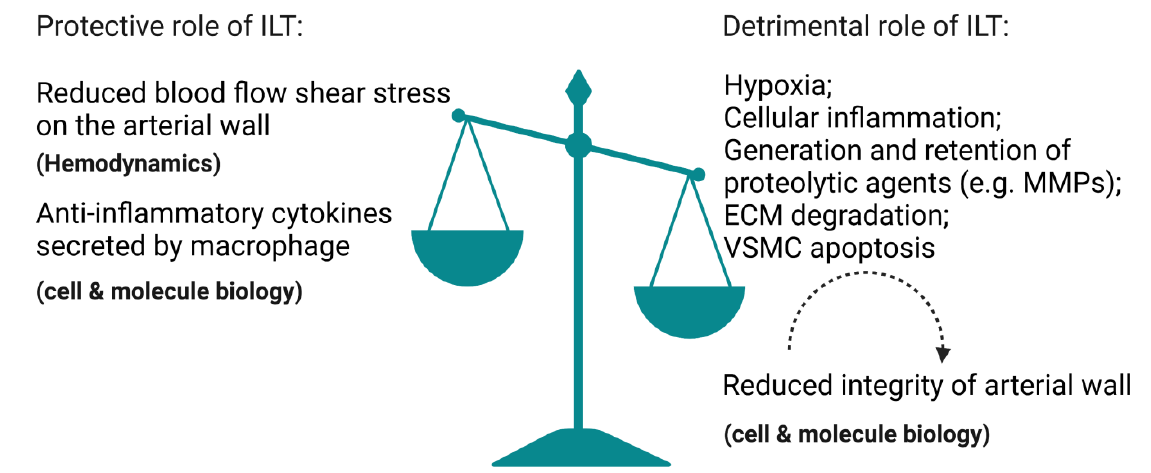
Figure 1. Illustration that demonstrates how the protective biomechanical advantage ILT provides via lowering wall stress is outweighed by weakening of the arterial wall. The illustration elements are from Biorender (https://biorender.com/) (accessed on 30 June 2022; Agreement number: TB243UY73N).